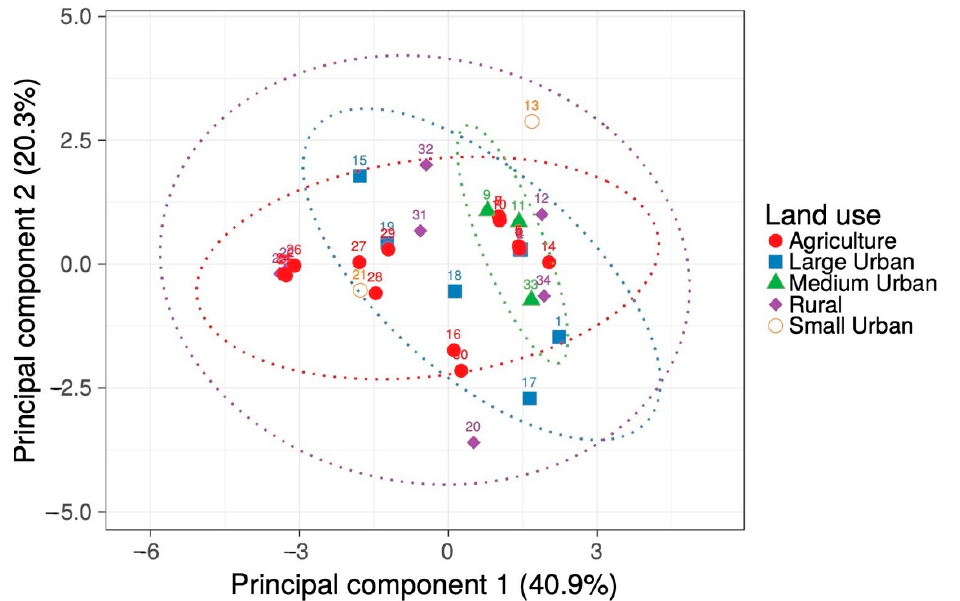
Figure 2. Principal Components Analysis for climate and soil characteristics from 34 collection sites with different land use. Data are plotted along the two main components from Table 2 for sites with agricultural (circles), large (squares), medium (triangles), and small (open circles) urban, or rural (diamonds) use. The numbers are the site identity from Figure 1. Ellipses indicate the 95% confidence interval for each land-use class. Percentages along the axes indicate the variance explained by each component. Table 2. Principal Components Analysis for climate and soil attributes from 34 sites in Sonora, Mexico. Data are the component loadings for each attribute considered and the percent of the variance explained by each component individually and cumulative. For each component, the p -values are from a Kruskal–Wallis test for the axis values for each land use class. Principal